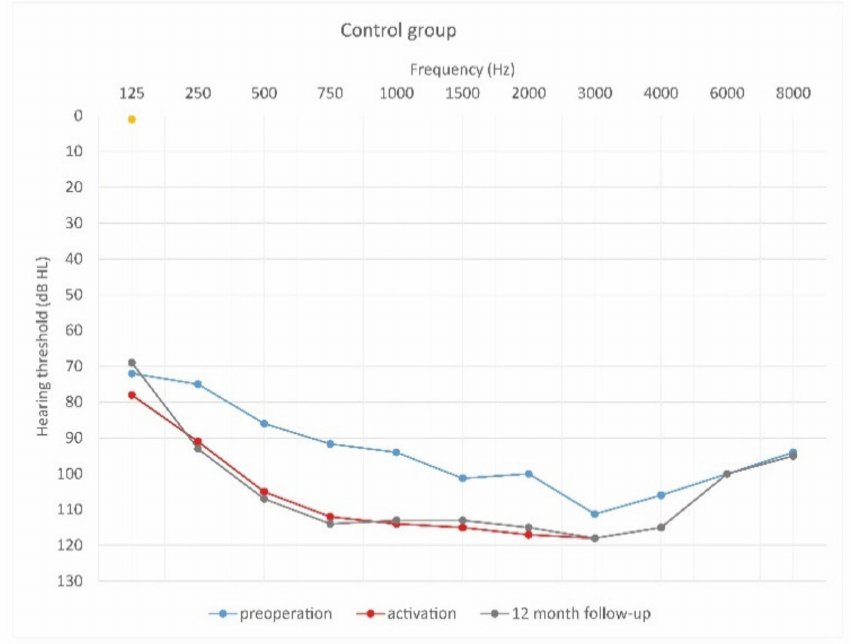
Figure 9. Mean hearing thresholds of control patients in the pre-operative period, upon activation, and in the twelve-month follow-up after CI